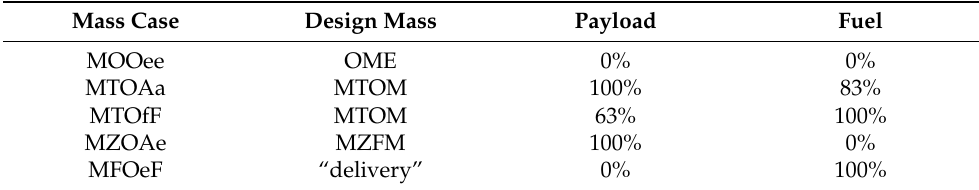
Table 3. Composition of the mass cases according to the payload and fuel combination.